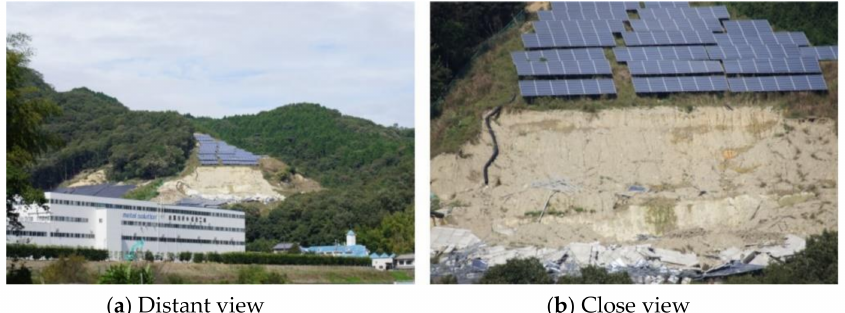
Figure 5. PV system damaged by a landslide. Photography by